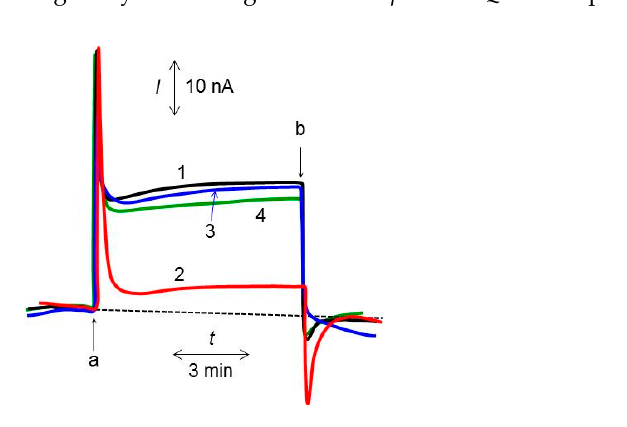
Figure 3. Time-course of the amperometric response measured using a R. sph. -DCBQ-CPE in the absence (curve 1) or presence of 5 μ M of KCN (curve 2), 100 μ M of phenol (curve 3) and 20 μ M of terbutryn (curve 4). Light illumination was applied between points “a” and “b.”